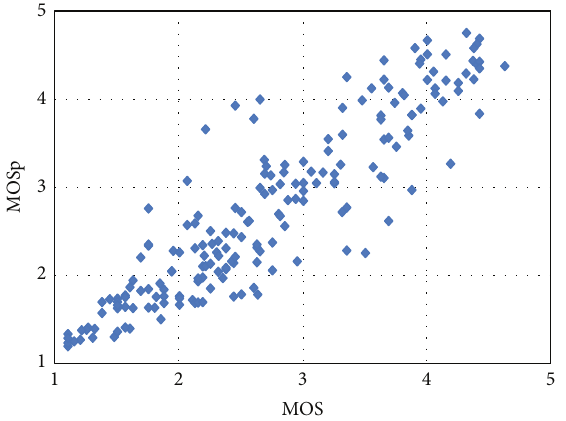
Figure 8: MOSp ( 𝑉 𝑞 ) versus MOS for the first set of measurements.